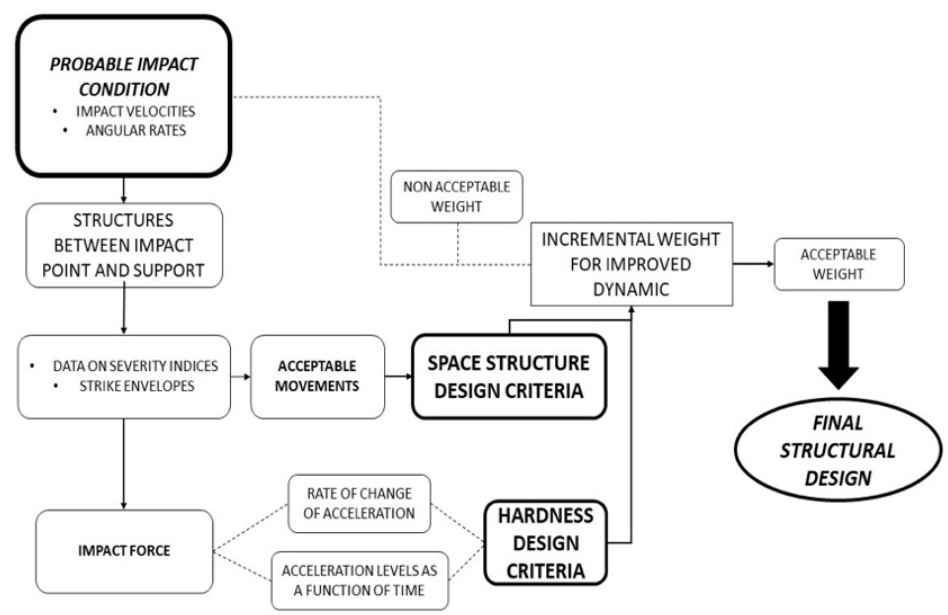
Figure 6. Concept Map: Design of Rupture-Controlled Structures Flow Chart. Failure